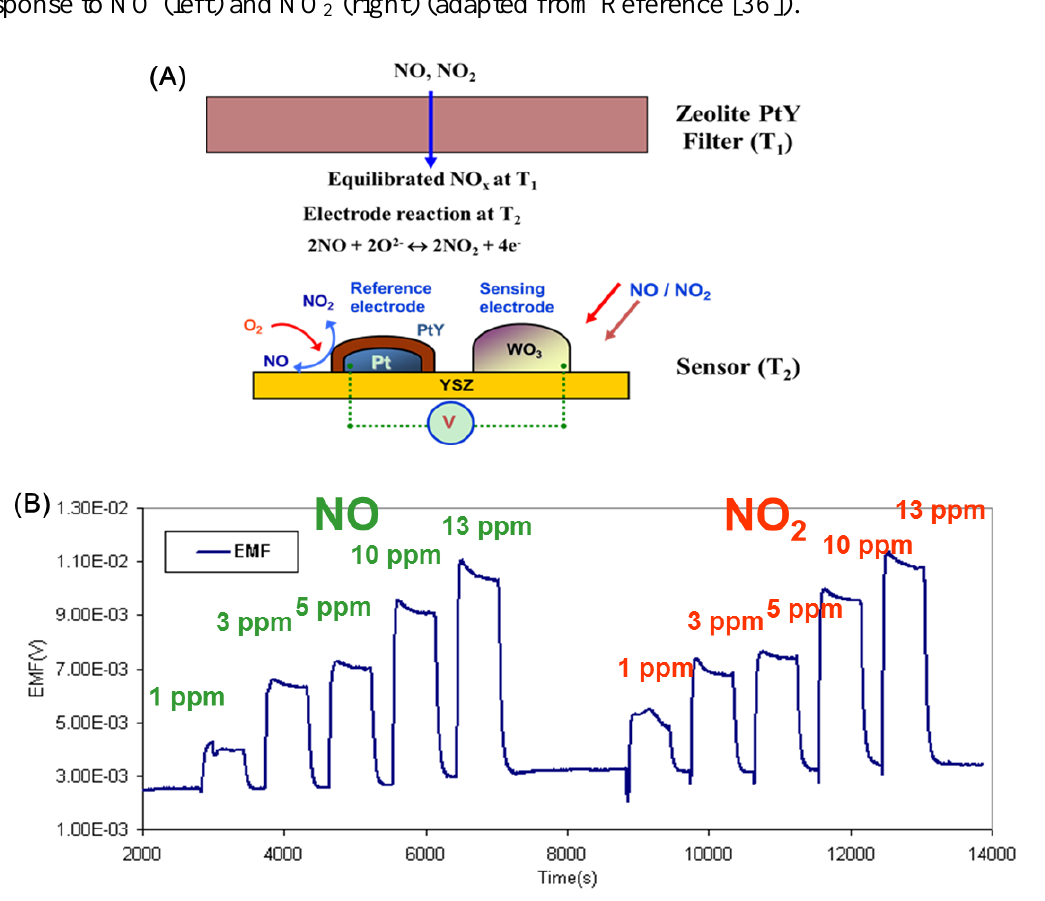
), YSZ sensor 1 ); ( B ) 2